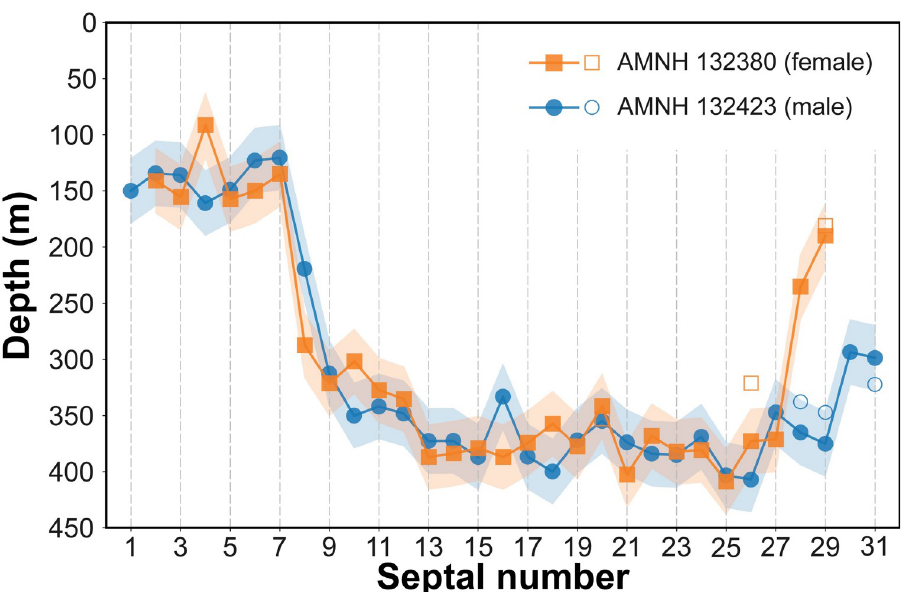
Fig 8. Reconstructed habitat depths of Nautilus macromphalus from New Caledonia. Filled markers represent the data produced at the University of California, Santa Cruz. Unfilled markers represent the data produced at the University of Michigan. Shaded areas represent the estimated error range calculated with the 95% confidence interval in Fig 7.